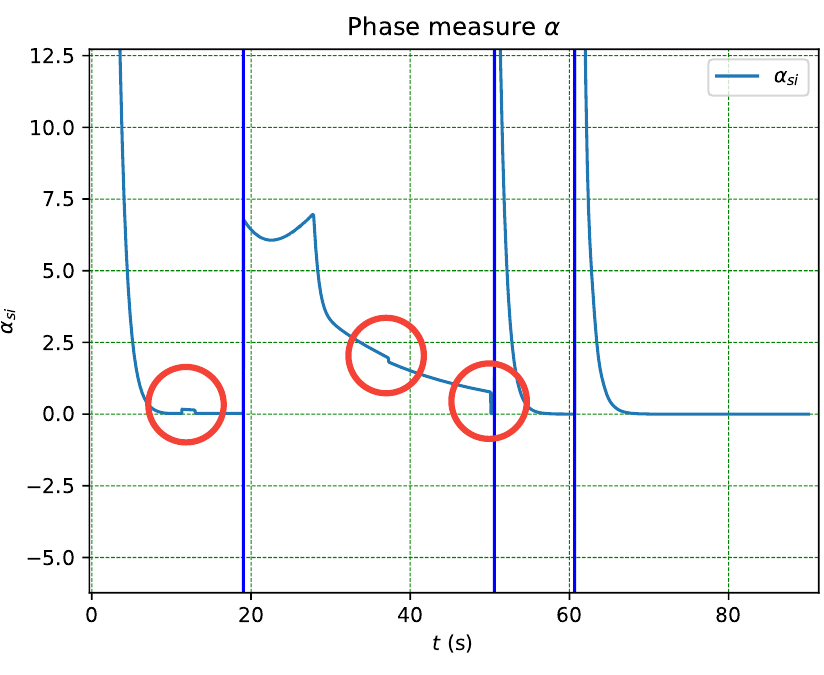
Figure 14. Close up of the Measure from Figure 15.